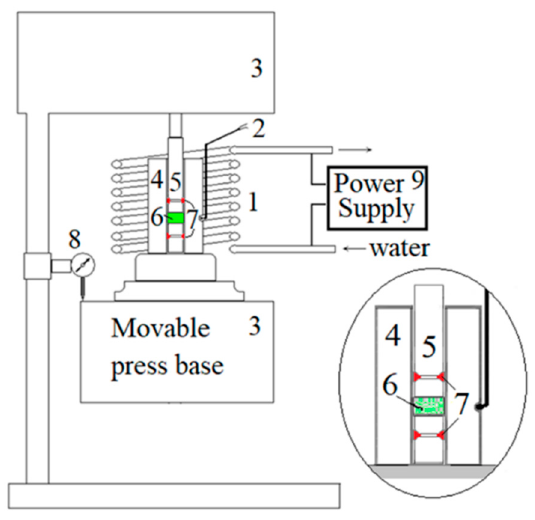
Figure 1. The CSP setup: 1—coil induction heater; 2—thermocouple; 3—hydraulic press; 4—die mold; 5—set of punches; 6—ZnO powder; 7—seal rings; 8—motion sensor; 9—Power Supply. Table 2. The CSP conditions.